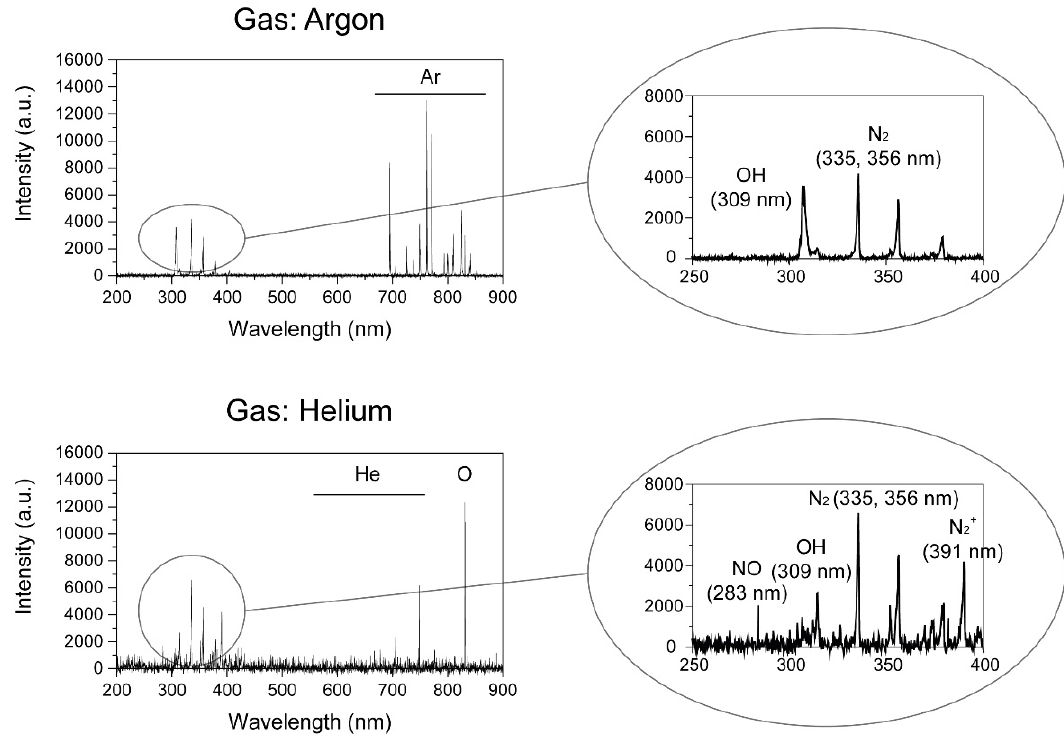
Figure 2. IV curve and electrical waveform of argon and helium plasma jets. The gas flow rates of argon and helium were fixed at 2 slm. ( A ) DC input voltage and DC Discharged current for argon and helium plasma. The breakdown voltage were 6 V for argon and 4 V for helium, The DC input voltage for transdermal permeability experiment were fixed 18 V and 12 V in argon and helium gas, respectively. ( B ) Waveforms of the inverted AC applied voltage and discharge current for the argon and helium plasma at DC input voltage 18 V and 12 V, respectively. The applied RMS voltages were 2.54 kV for argon and 1.73 kV for helium, and their RMS discharge currents were 11.01 mA and 6.21 mA, respectively.